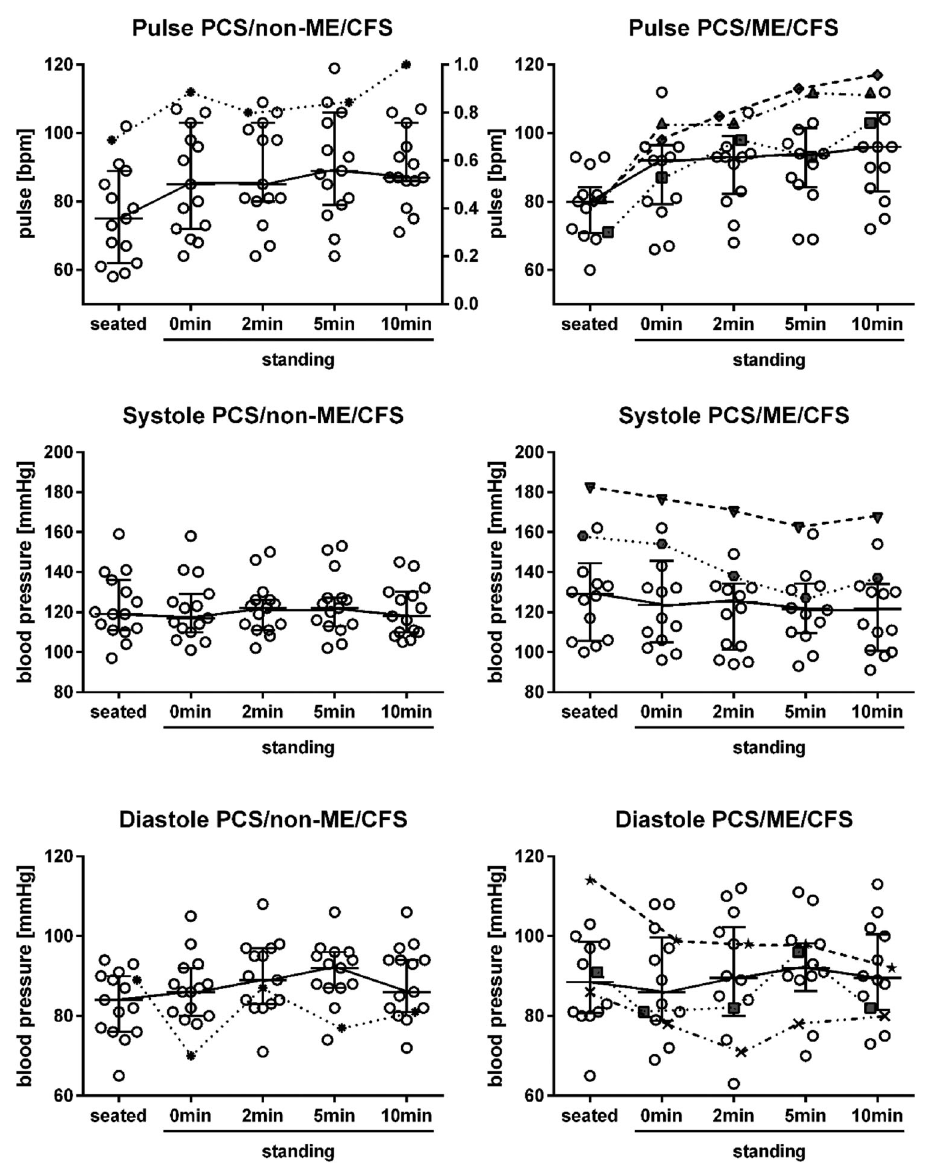
Fig. 4 | Sitting and standing heart rate and blood pressure in female patients. PCS/non-ME/CFS post-COVID-19 syndrome/non-myalgic encephalomyelitis/ chronic fatigue syndrome; PCS/ME/CFS post-COVID-19 syndrome/myalgic ence- phalomyelitis/chronic fatigue syndrome; BP blood pressure; POTS postural orthostatictachycardiasyndrome.Heartrate(pulse)aswellassystolic(systole)and diastolic (diastole) BP sitting, standing, and after 2, 5, and 10min standing in